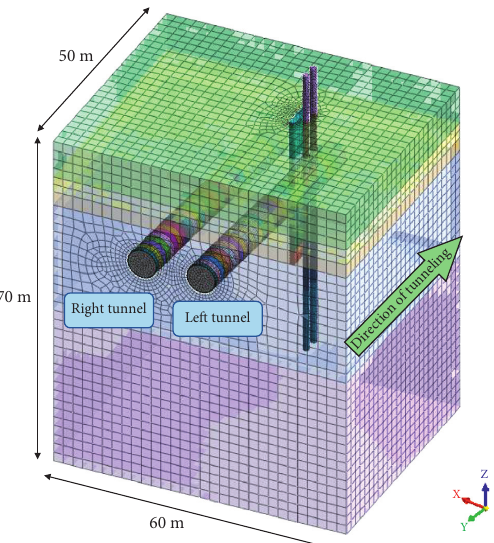
Figure 5: Three-dimensional finite element